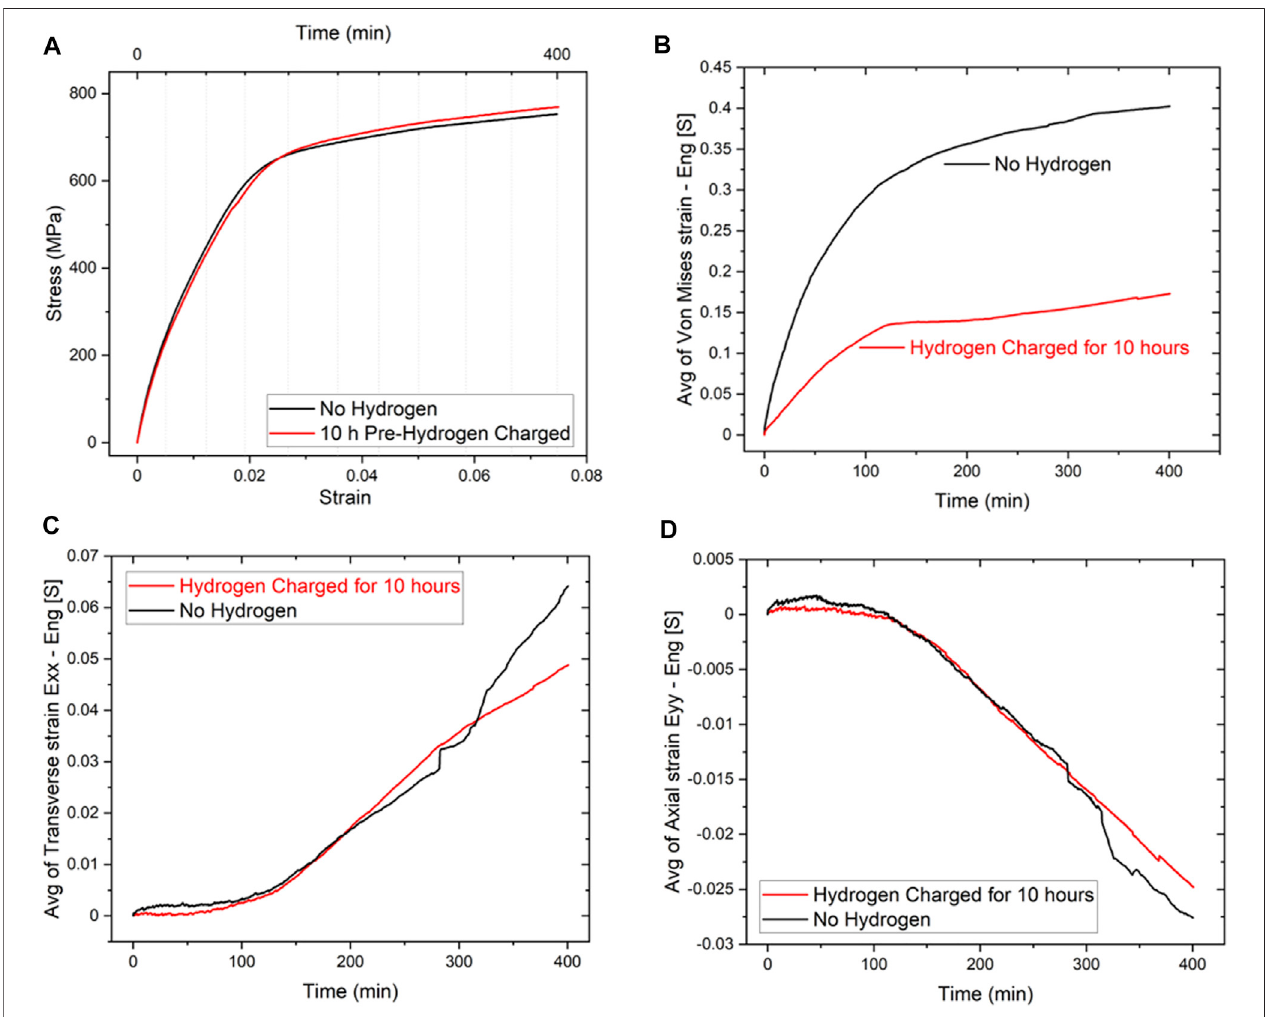
FIGURE15|(A) Stress-straincurves ofthetested microstructuresuntil 7.5%macroscopic strain(measured bythetester ’ sextensometer), (B) computed average von Mises strain of the entire imaged microstructure, (C) average Exx strain, and (D) average Eyy strain.